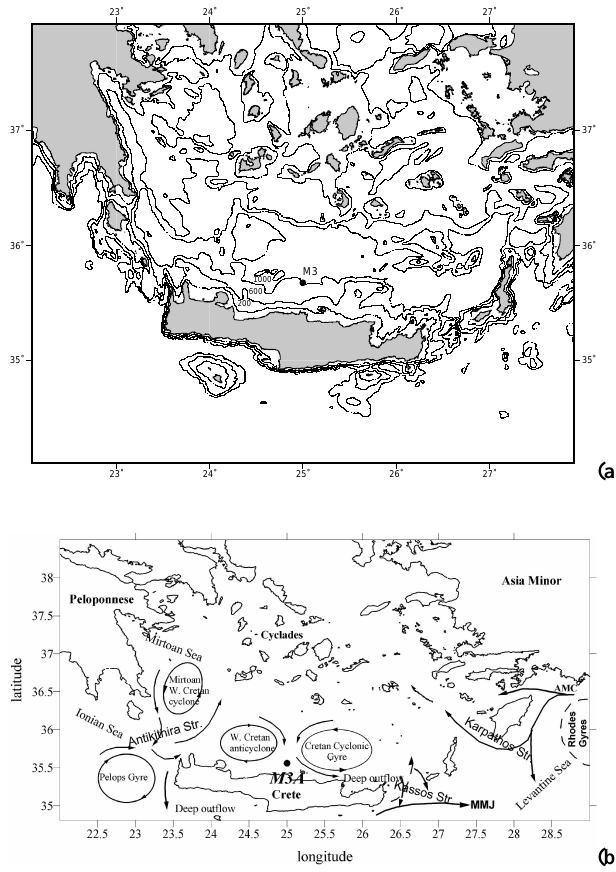
Fig. 1. (a) Bathymetric chart of the Cretan Sea and (b) Location of the M3A (dot) buoy and schematic configuration of the main upper thermocline circulation features (modified from Theocharis et al., 1999b).